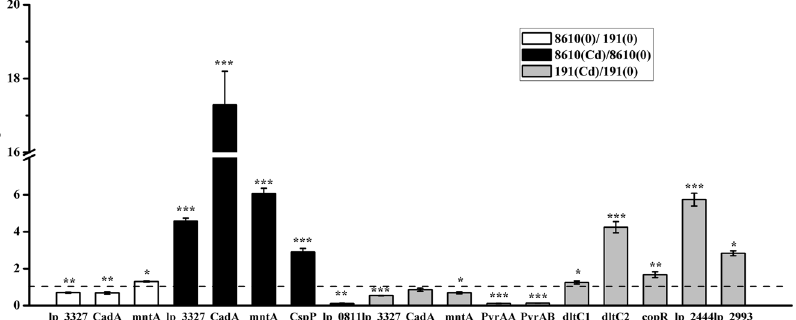
Figure 5. Relative mRNA expressions of genes encoding proteins altered in three comparisons, including CCFM8610(0)/CCFM191(0), CCFM8610(Cd)/CCFM8610(0) and CCFM191(Cd)/CCFM191(0). Values are expressed as mean ± SEM of 4 independent replicates. mRNA expression of denominator in each comparison is set as reference value of 1. * P < 0.05; ** P < 0.01; *** P <